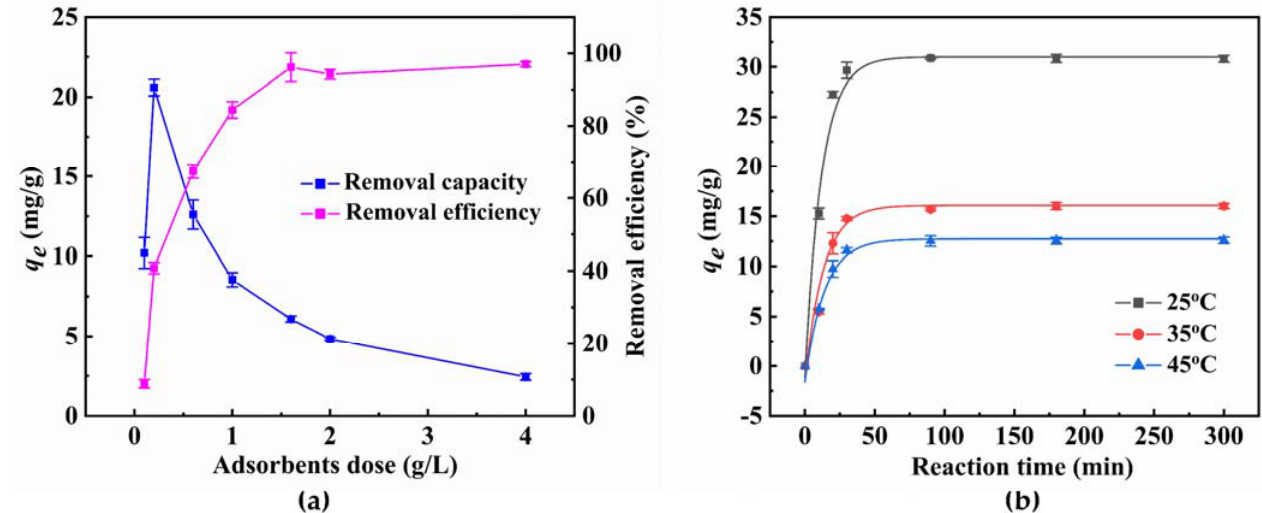
Figure 3. Influence of adsorbent dose ( a ) and temperature ( b ) on 4 − NP uptake for Mg/Si 1:6.